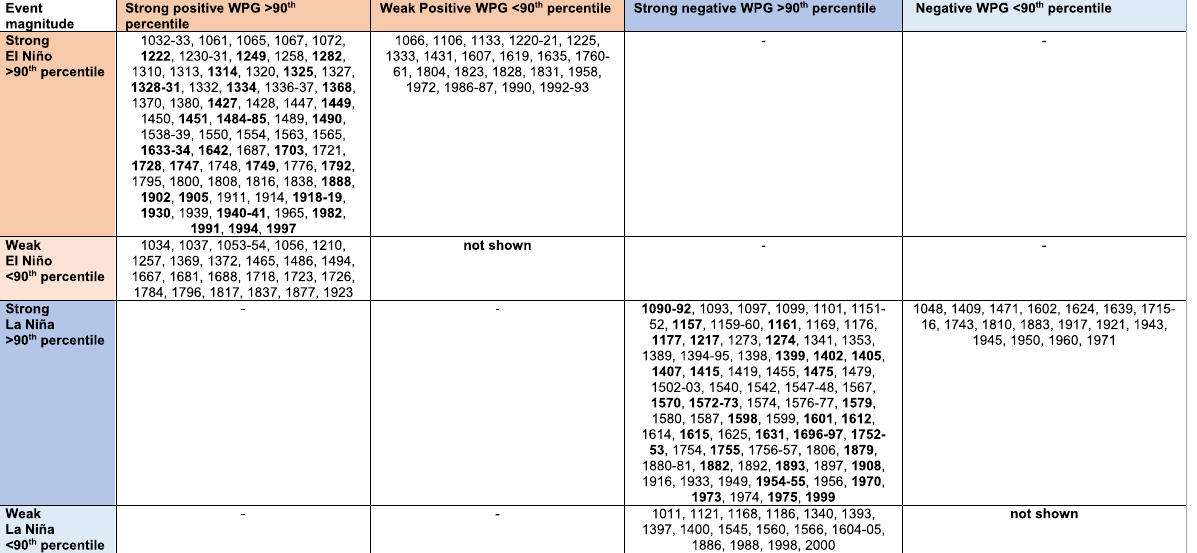
(Figs. 5, 6). Negative WPG extremes all resemble La Niña-like SST patterns (Figs. 5a-c; 6a-c). Negative WPG extremes at the turn of the 14th to the fifteenth centuries and the sixteenth to the seventeenth centuries share similar SST spatial patterns with maximum cooling in the central (Niño4 region) and eastern Pacific (Niño3.4 region). The positive WPG extremes appear more variable in their spatial SST footprint, though all these extremes